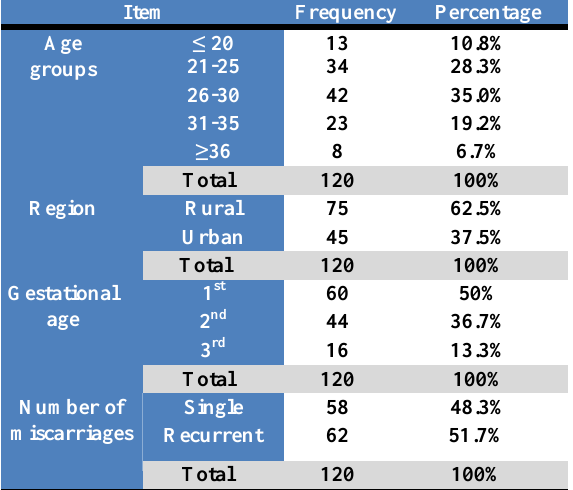
1: The distribution of demographic characteristics of the abortive